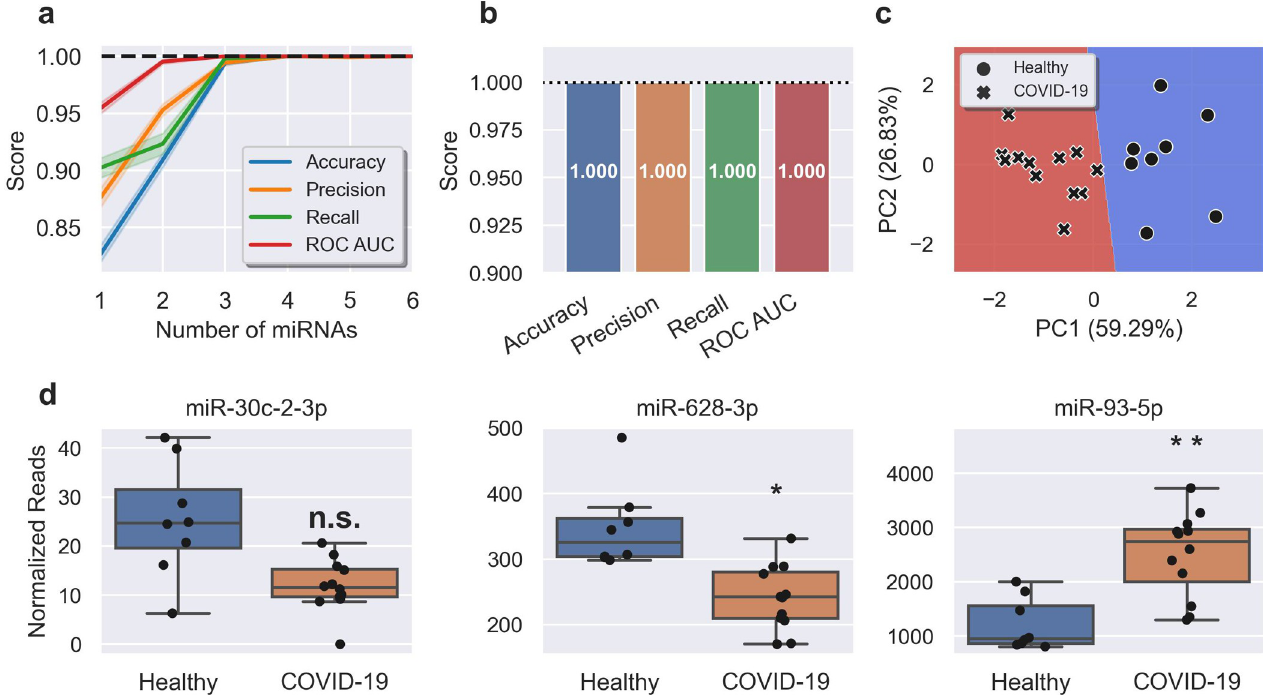
Fig 4. A miRNA signature in nasal swabs classifies COVID with 100% accuracy. A, Feature (miRNA) selection lineplot showing the impact of increasing numbers of miRNAs on the performance of a logistic regression model. MicroRNAs were selected using recursive feature elimination to identify the most important miRNAs. Each combination of miRNAs was randomly assessed 1,000 times. Shaded areas are the 95% CI, and the dotted line is a perfect (100%) score. B, Barplot showing the average score of the three-miRNA signature in predicting healthy controls and COVID-19 patients. Error bars are the 95% CI after 1,000 random iterative assessments. C, Decision boundary graph showing the logistic regression decision point (solid black line) and the probability a person is infected with SARS-CoV-2 (blue to red shading). Datapoints are healthy (circles) and COVID-19 (crosses) samples. D, Boxplots of each of the signature miRNAs in healthy (blue) and COVID-19 (orange) samples. Boxes are the 25 th - 75 th percentile, line is the median, and whiskers are 1.5x IQR. � FDR adjusted p-value < 0.05, �� FDR adjusted p-value < 0.01. n.s. non-significant.